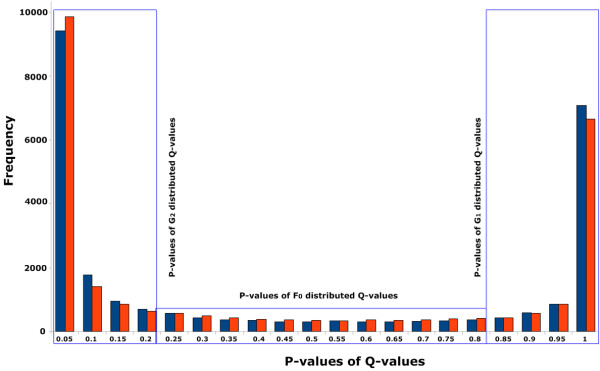
p-value distributions ofℚent andℚsep-values for human EGFR protein (PDB-Entry 2J6M). The blue bars illustrate the p-value distribution of the ℚent-values and red bars display the p-value distribution of the ℚsep-values.